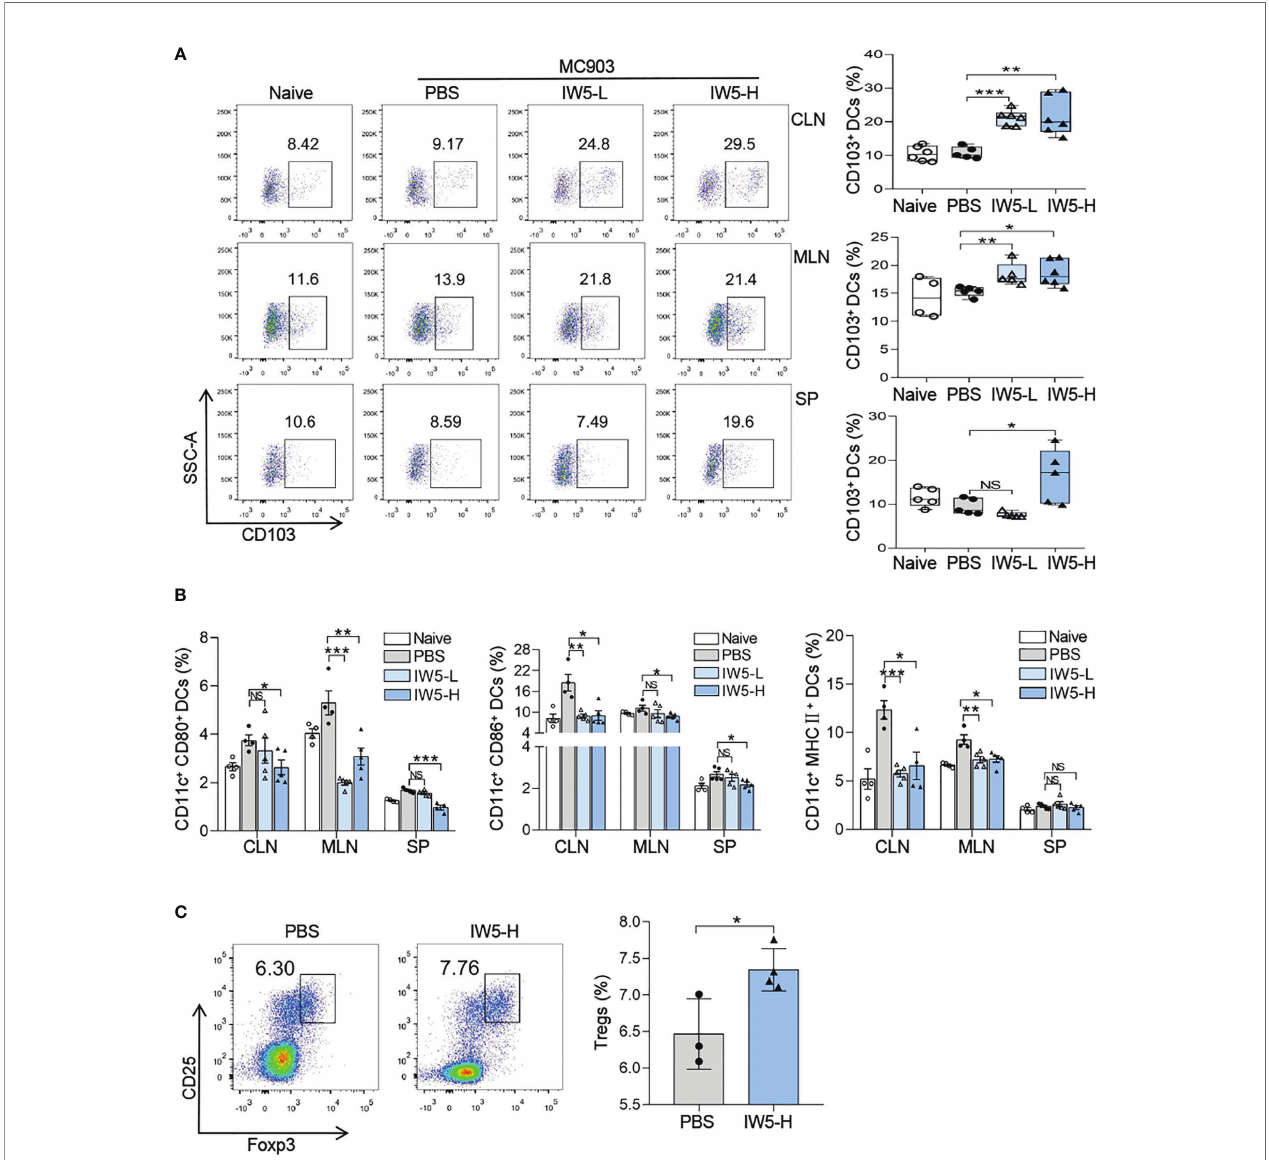
FIGURE 3 | IW5 promotes DCregs expansion and Tregs differentiation. (A, B) AD mice were orally administrated with IW5-L or IW5-H daily for 27 days, and the CLNs, MLNs, and spleens were collected on day 40 for further analysis. CD103 + DCs (CD11c + MHCII + CD103 + ) were examined by fl ow cytometry (A) . Expression levels of CD80, CD86, and MHCII on CD11c + DCs were examined by fl ow cytometry (B) . (C) BALB/c mice were orally administrated with IW5-H daily for 20days. CD11c + DCs from the MLNs were co-cultured with CD4 + T cells from naive mice spleens for 5 days. The proportion of CD4 + CD25 + Foxp3 + Tregs was measured by fl ow cytometry. Data are shown as means ± SEMs, and representative of data from three independent experiments. Student ’ s t-test (unpaired; n = 3~6); *P < 0.05, **P < 0.01, ***P < 0.001 vs. PBS group. NS, not signi fi